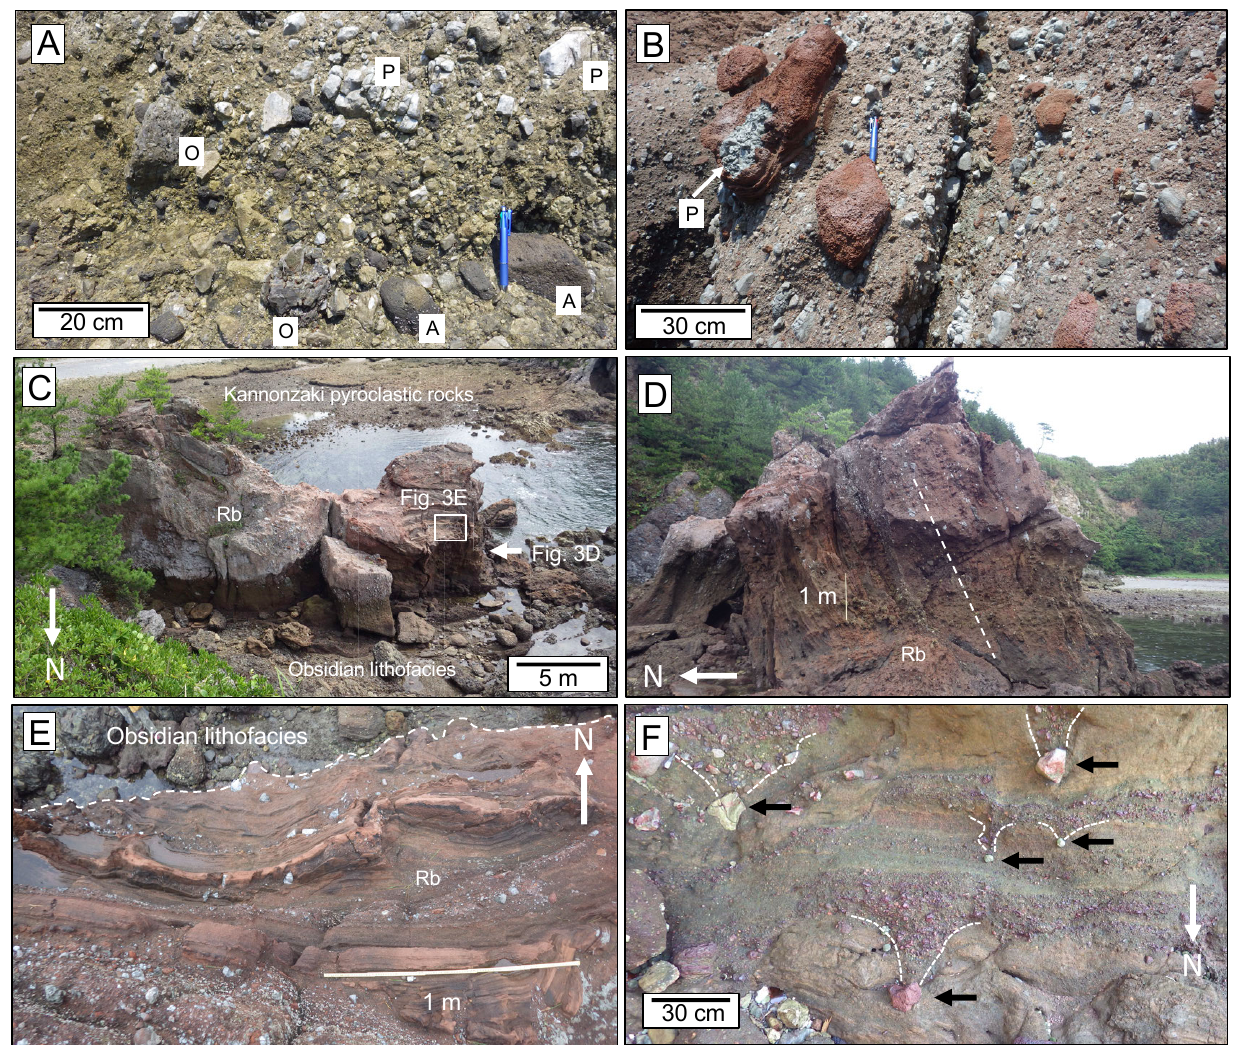
Figure 3: [A] Tuff breccia of the Kannonzaki pyroclastic rocks. The clasts of obsidian lava (O), perlitic lava (P), and rounded andesite (A) are included. [B] The reddish pyroclastic rocks are also included as clasts. The clasts oc- casionally contain perlitic clasts. [C] Photograph (view to the south) showing the rotated block of the Kannonzaki pyroclastic rocks (Rb) in the north margin of the bay. [D] Photograph (view to the east) showing the rotated block of the Kannonzaki pyroclastic rocks. The dotted line shows steep southward dipping of the bedding plane. [E] Upper surface of the block. The upper side of this photo shows the northern region, and the dotted line indicates boundary between the Kannonzaki pyroclastic rocks and obsidian lithofacies. The pyroclastic rocks are strongly deformed near the boundary. [F] The bomb sag structures (dotted lines and black arrows) developed in the